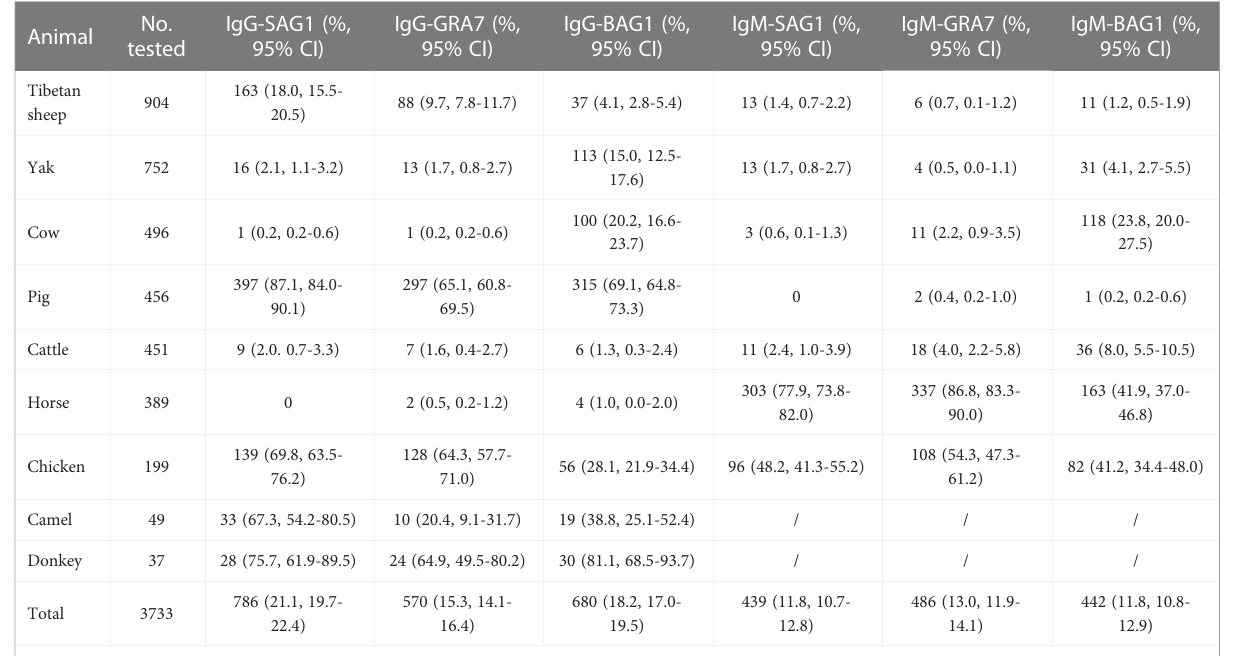
TABLE 2 Animals with seropositive for both IgG and IgM antibodies in rSAG1-ELISA, rGRA7-ELISA and rBAG1-ELISA tests. Animal